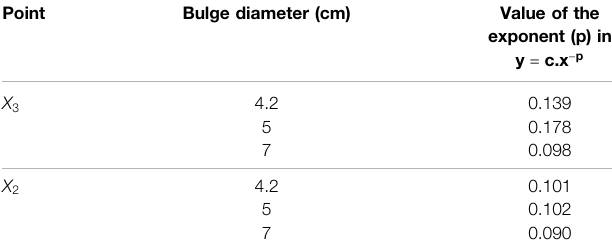
TABLE 3| Exponentofthepowerlawfordifferentpointsofthesensitivity analysis. Point Bulge diameter